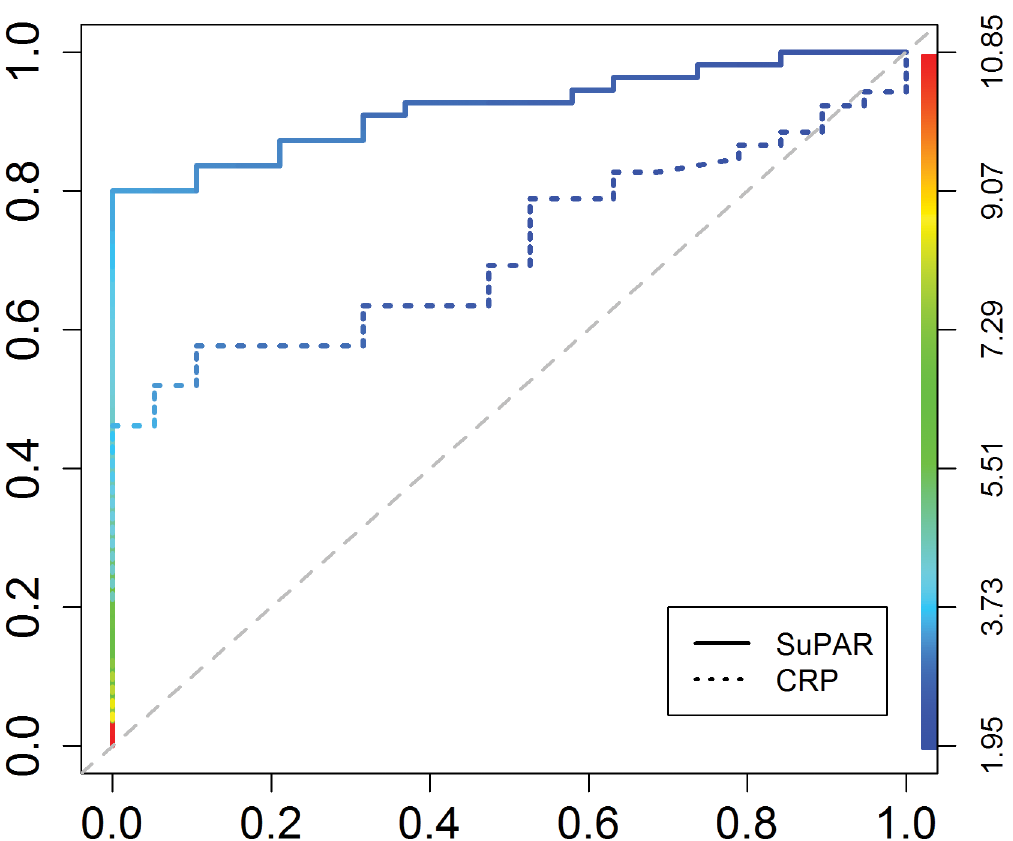
Fig 2. suPAR levels discriminates between healthy controls and suicide attempters better than CRP levels. ROC curve analysis of controls and suicide attempters as a state variable (the positive actual state is “ suicide attempter ” ), and suPAR and CRP as classifiers. The color key on the right y-axis illustrates the spectrum of different cut-off values of suPAR levels. Left y-axis = true positive rate, x-axis = false positive rate. The area under the curve (AUC) for suPAR = 0.915 and CRP = 0.715. The significance of the difference between the areas below the curves of suPAR and CRP equals p = 0.0053.